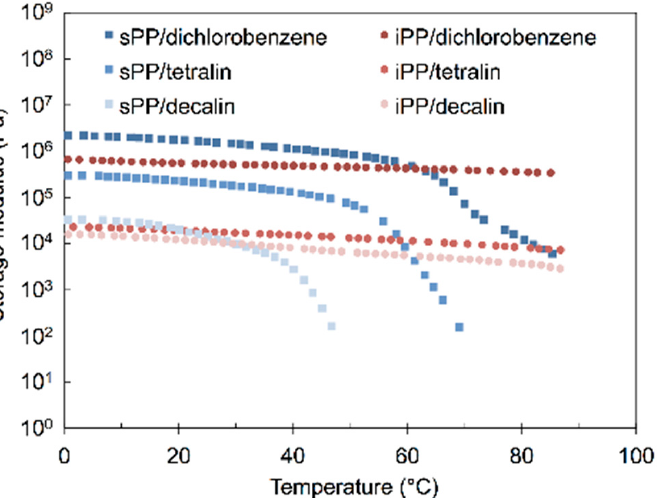
Figure 9. Storage moduli of PP/tetralin10, PP/decalin10, and PP/dichlorobenzene10 gels as a function of temperature.